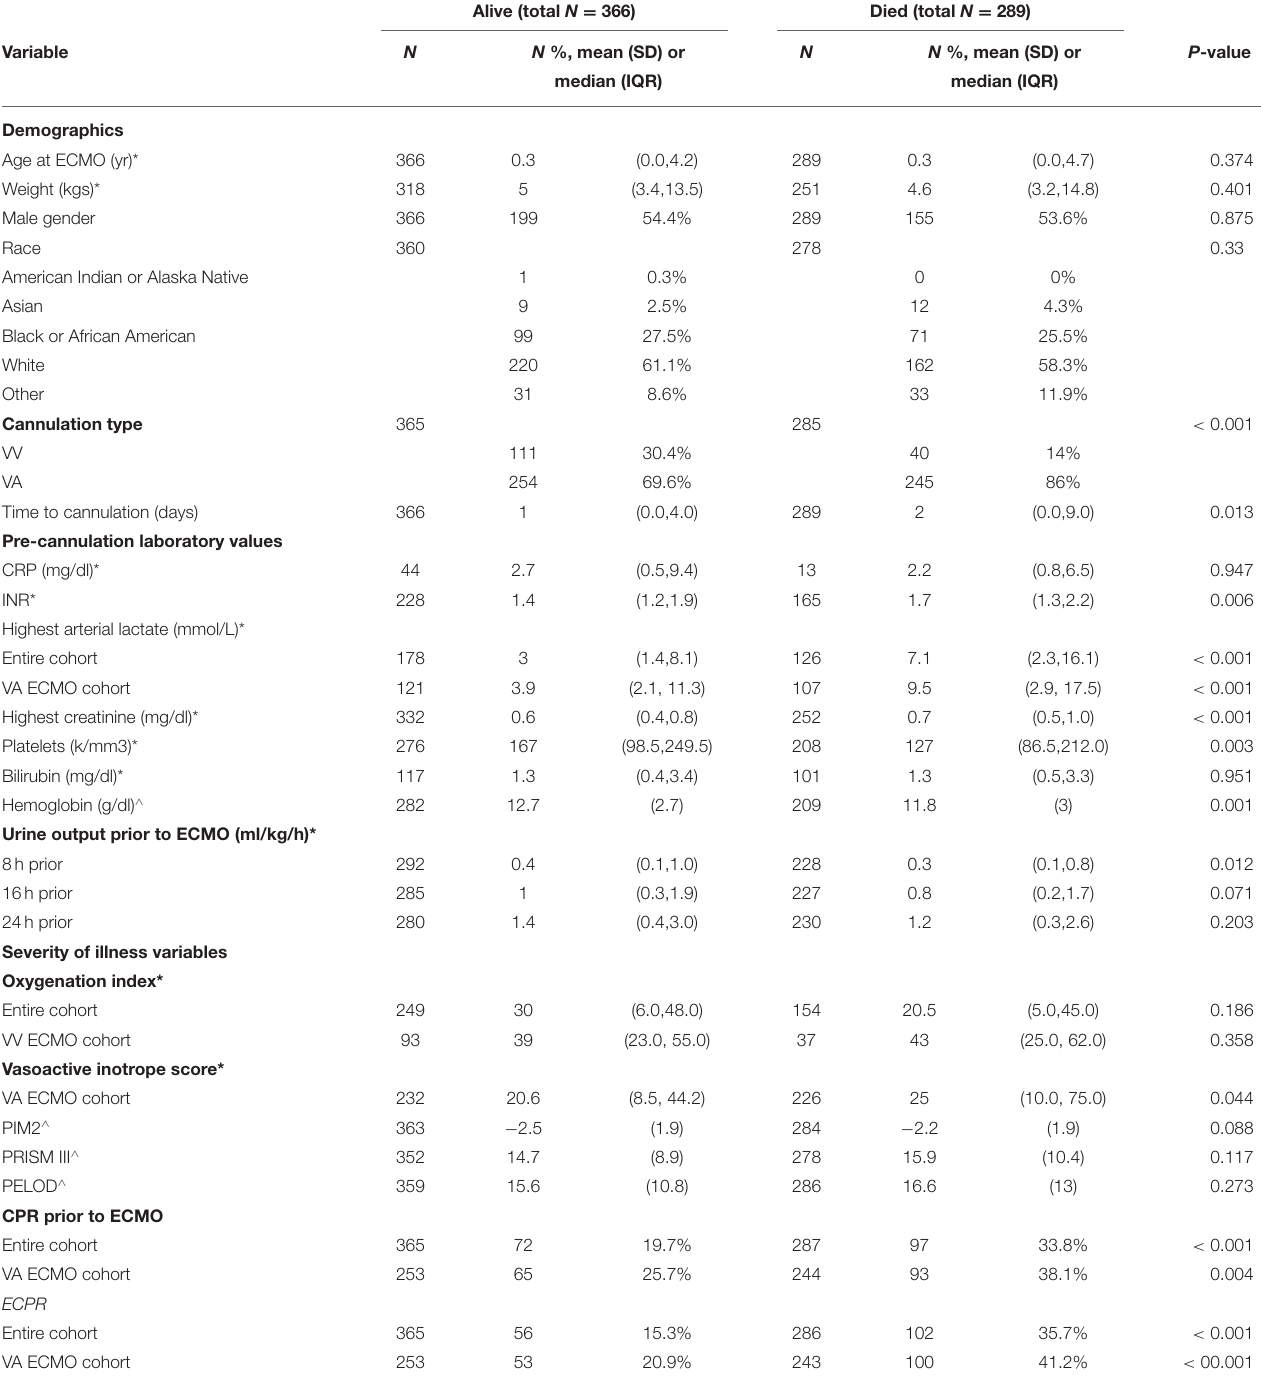
TABLE 1 | Summary statistics compared between survivors and non-survivors at time of